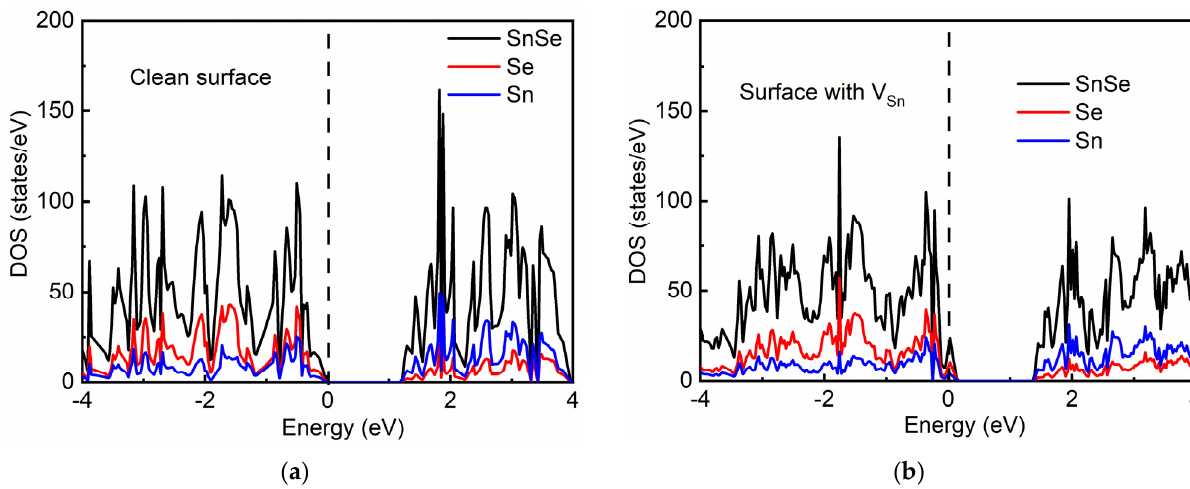
Figure 6. Density of states of two different surfaces. ( a ) Clean SnSe monolayer surface. ( b ) SnSe monolayer surface with one Sn defect.